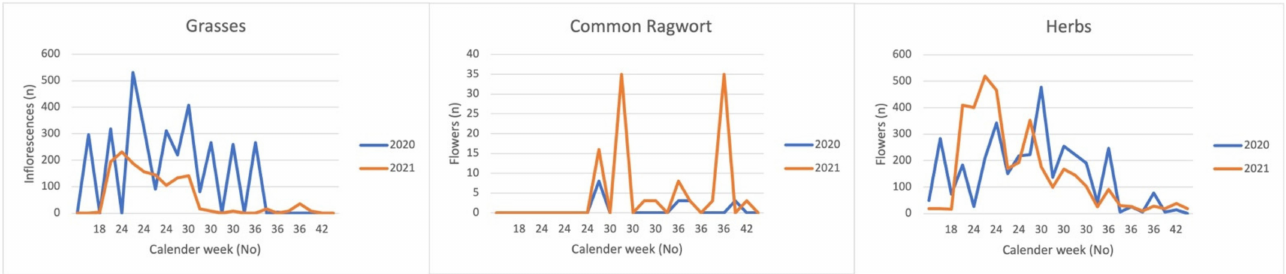
Figure 7. Number of flowers of ragwort, other herbs, and grasses in both years per calendar week.